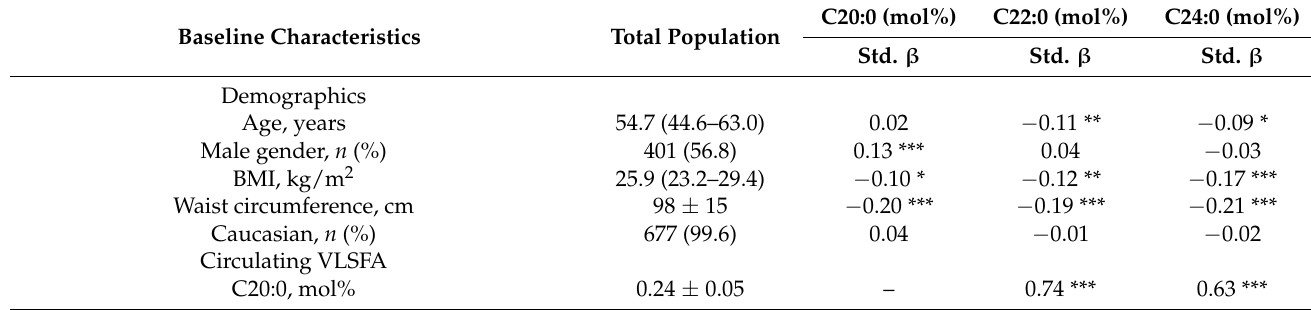
Table 2. Baseline characteristics of the KTR cohort and univariable association of circulating VLSFA concentrations across clinical